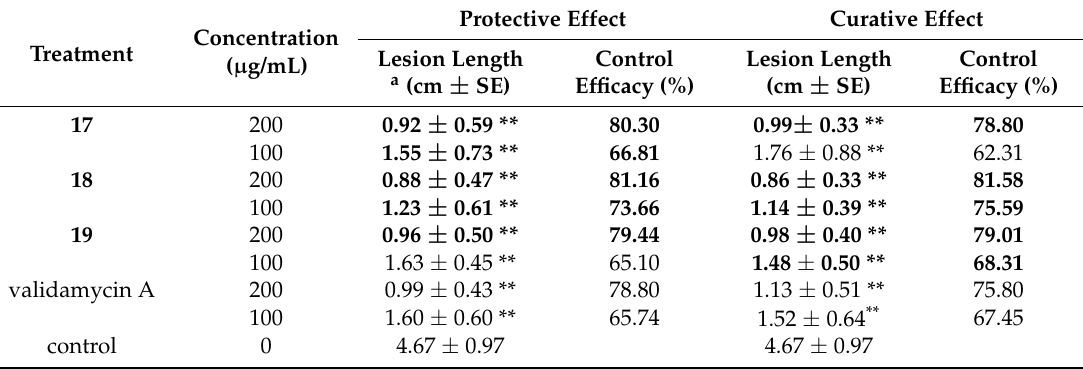
Table 4. In vivo protective and curative effects against R. solani using greenhouse experiment.